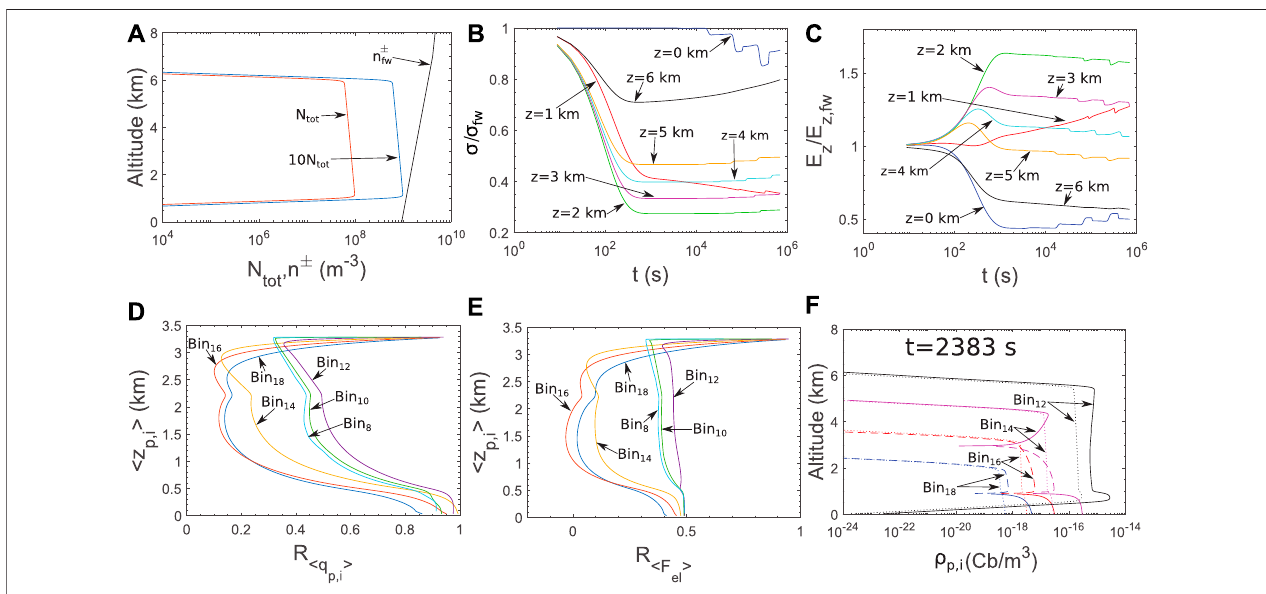
FIGURE 10 | Comparison between the case of N I p , i and the case of 10 N I p , i : (A) Total particle number density compared to the ambient fair weather ion density, (B) conductivity reduction with respect to the fair weather value at different altitudes over time for 10 N I p , i , (C) electric fi eld magnitude modi fi cation with respect to the fair weather value at different altitudes over time for 10 N I p , i , (D) average particle charge ratio between N I p , i and 10 N I p , i , for several bins, (E) average electrical force ratio between N I p , i and 10 N I p , i , for several bins, (F) snapshot of particle charge density distribution for some bins in the case of 10 N I p , i . With solid lines are the negative values, with dashed lines are the positive values and with dotted lines are the values of the charge density distributions in the case of N I p , i (which are all negative).